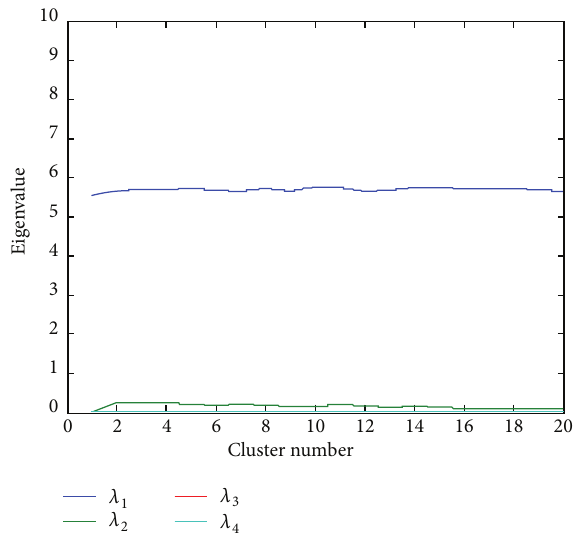
F 7: MIMO capacity comparison.